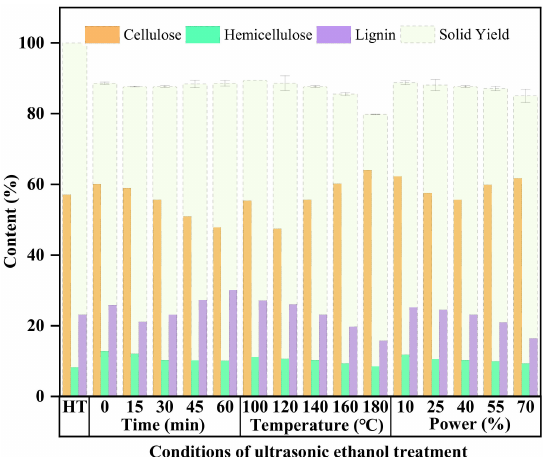
Figure 2. Effect of different ultrasonic ethanol treatments on solid product yields and